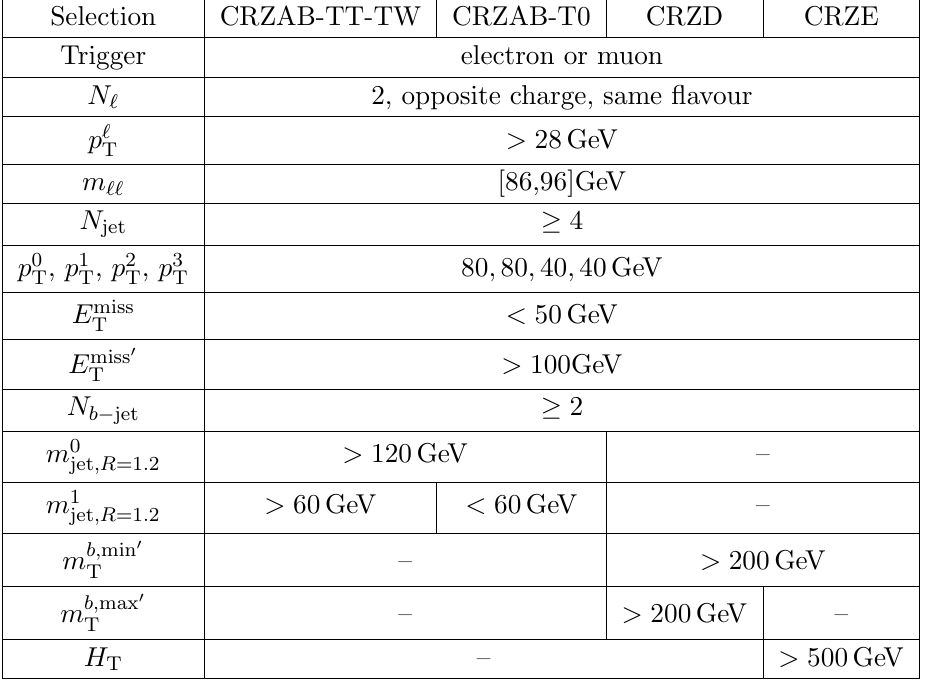
Table 5. Selection criteria for the Z + jets control regions used to estimate the Z + jets background contributions in the signal